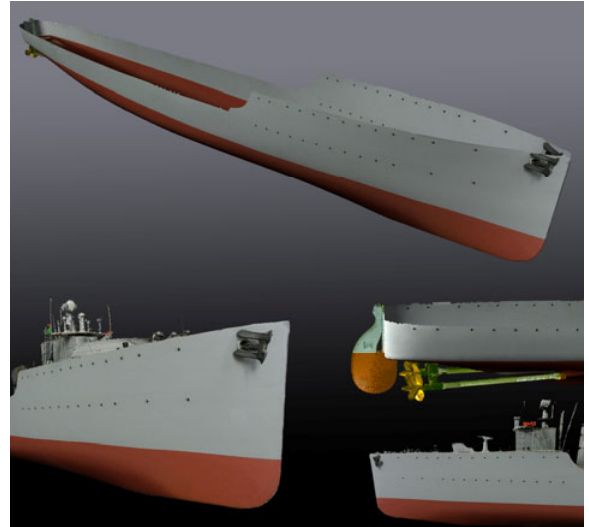
Figure 10: Photorealistic texture mapping of bow and forecastle